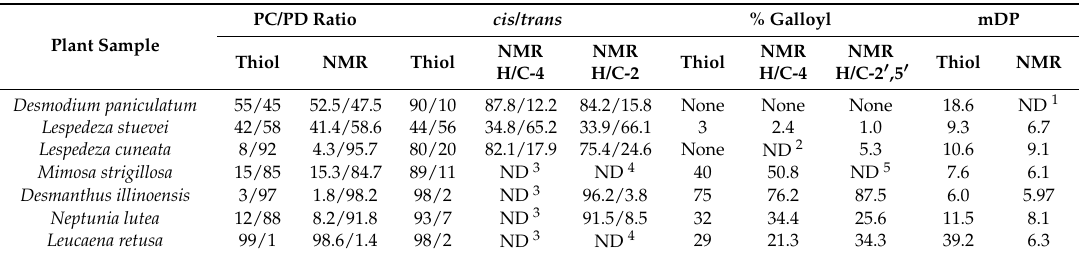
Table 2. Comparison of structural information obtained from thiolysis and 1 H- 13 C HSQC NMR.